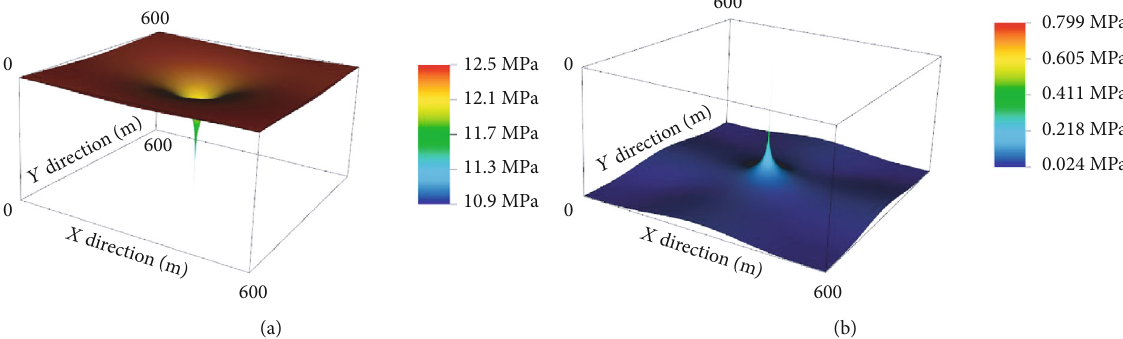
Figure 4: Surface maps of (a) pressure distribution after one day of shallow water fl ow and (b) von Mises stress distribution after one day of shallow water fl ow in the sediments.